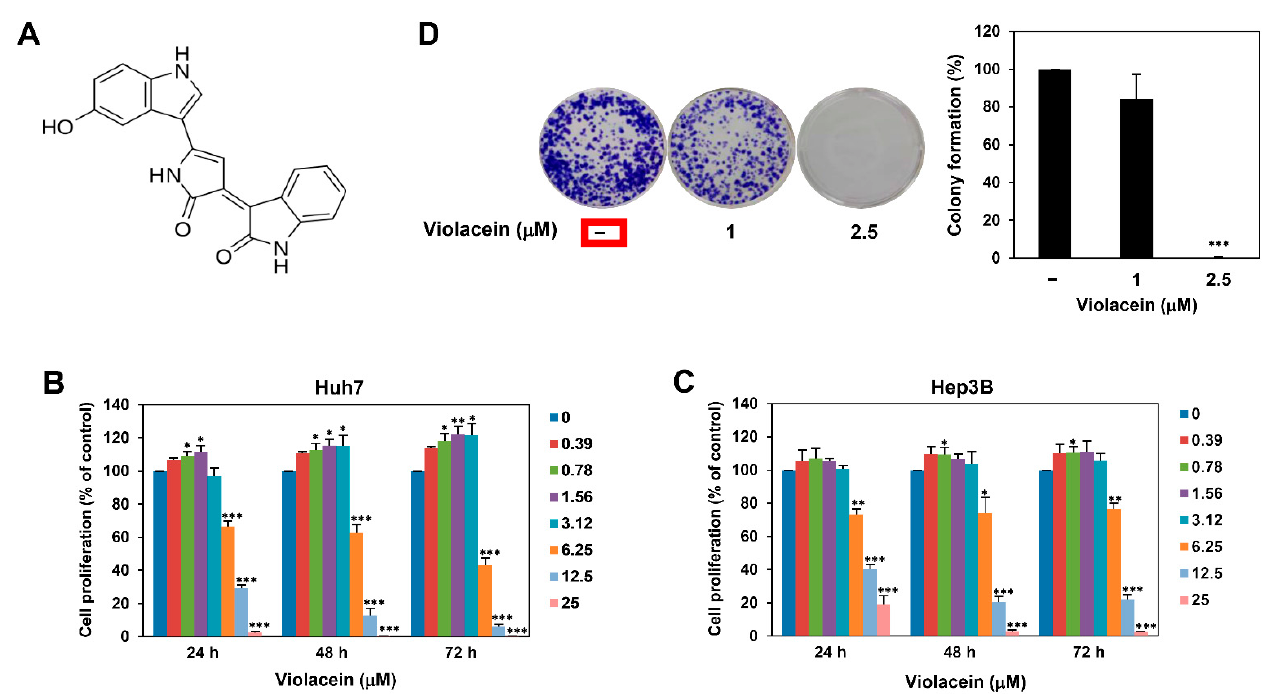
Figure 1. Violacein inhibits the proliferation of Huh7 HCC cells. ( A ) Chemical structure of violacein. ( B , C ) Effect of violacein on the proliferation of Huh7 and Hep3B cells. The cells were treated with violacein at various concentrations (0–25 µ M) for 24, 48, or 72 h. Cell proliferation was measured using the CellTiter-Glo ® luminescent assay system. ( D ) Effect of violacein on the colony-forming ability of Huh7 cells. The cells were incubated in the absence or presence of violacein (1 and 2.5 µ M) for 12 days. The cell colonies were detected by crystal violet staining. ∗ p < 0.05, ∗∗ p < 0.01, ∗∗∗ p < 0.001 vs. the control.